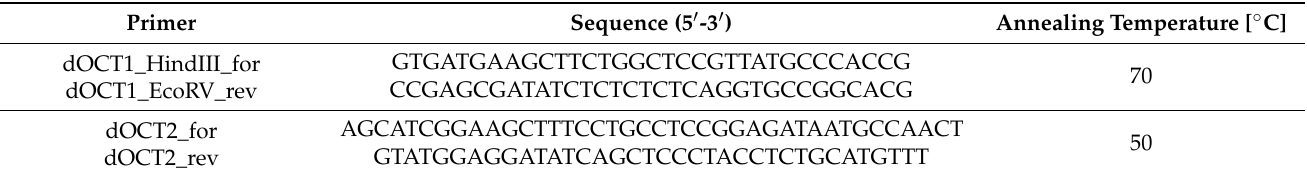
Table 3. Sequences and annealing temperatures of primers used for cloning dog OCT1 and